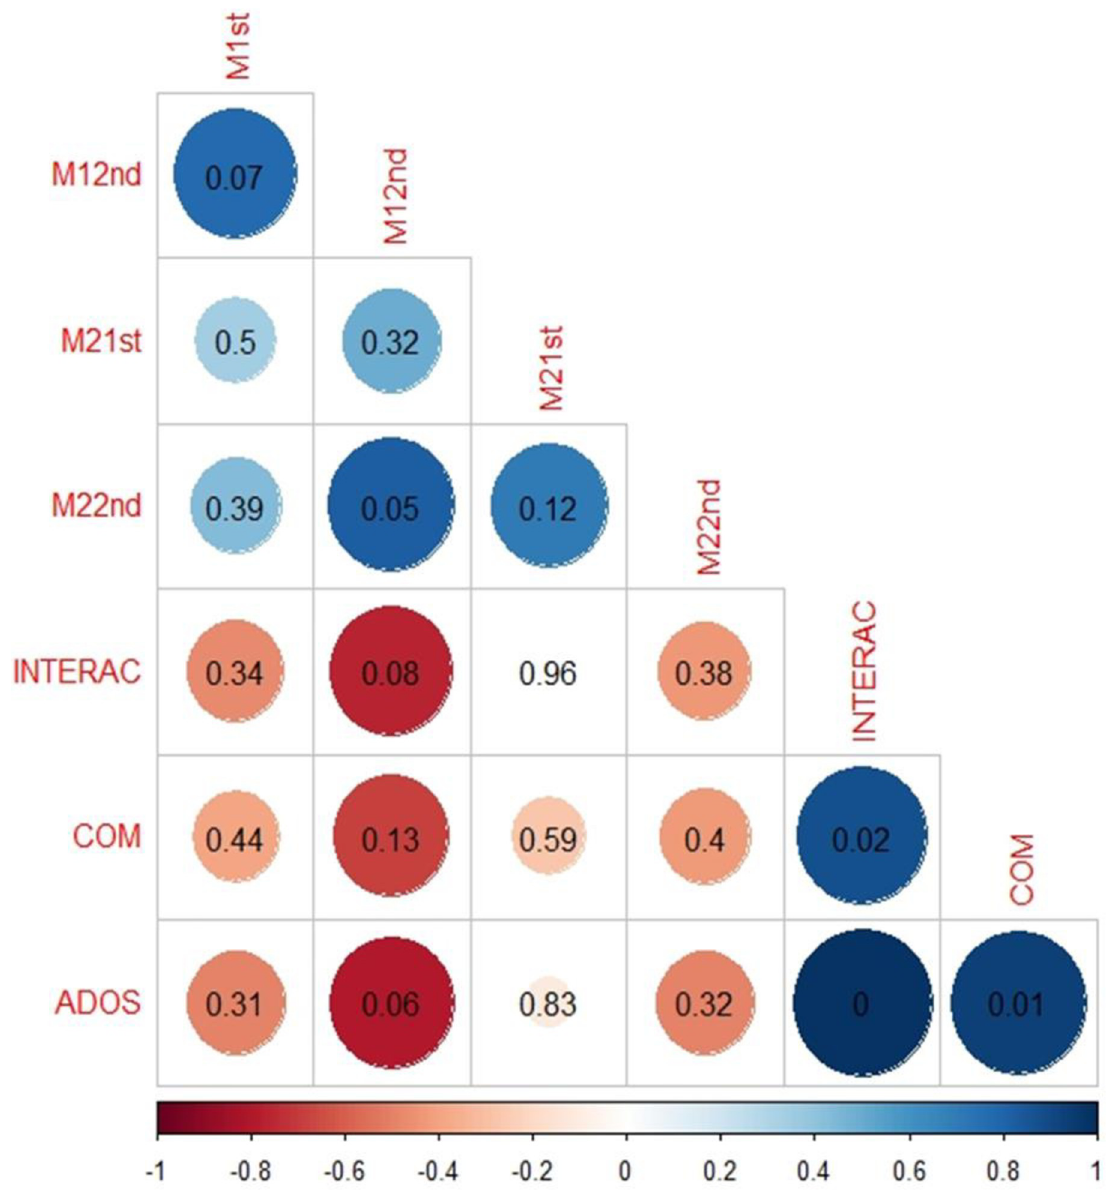
Fig 5. Spearman’s correlation analyses of different pairs of variables (various colours) and the associated p-value (indicated by the text).